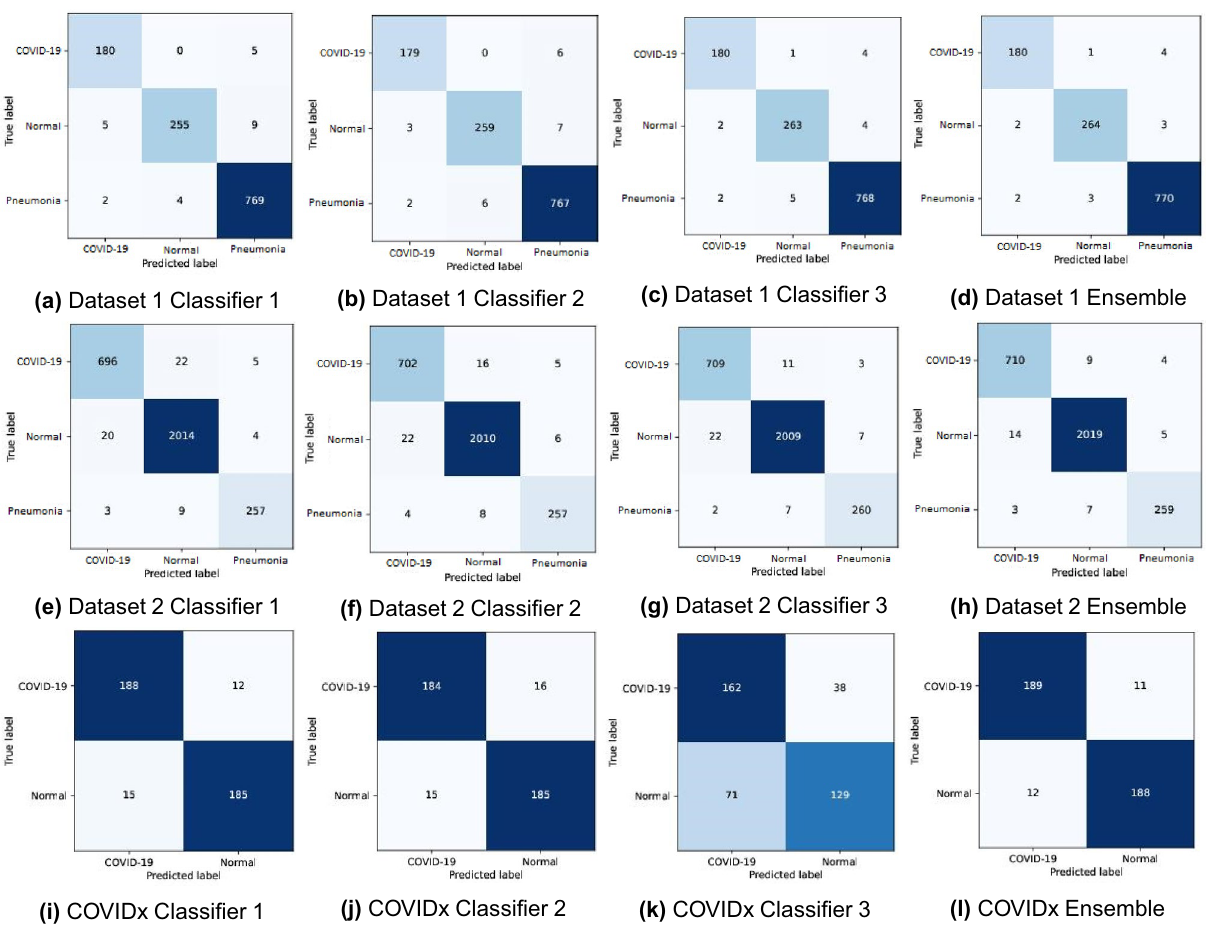
Figure 6. Confusion matrices obtained on Dataset-1, Dataset-2 and COVIDx